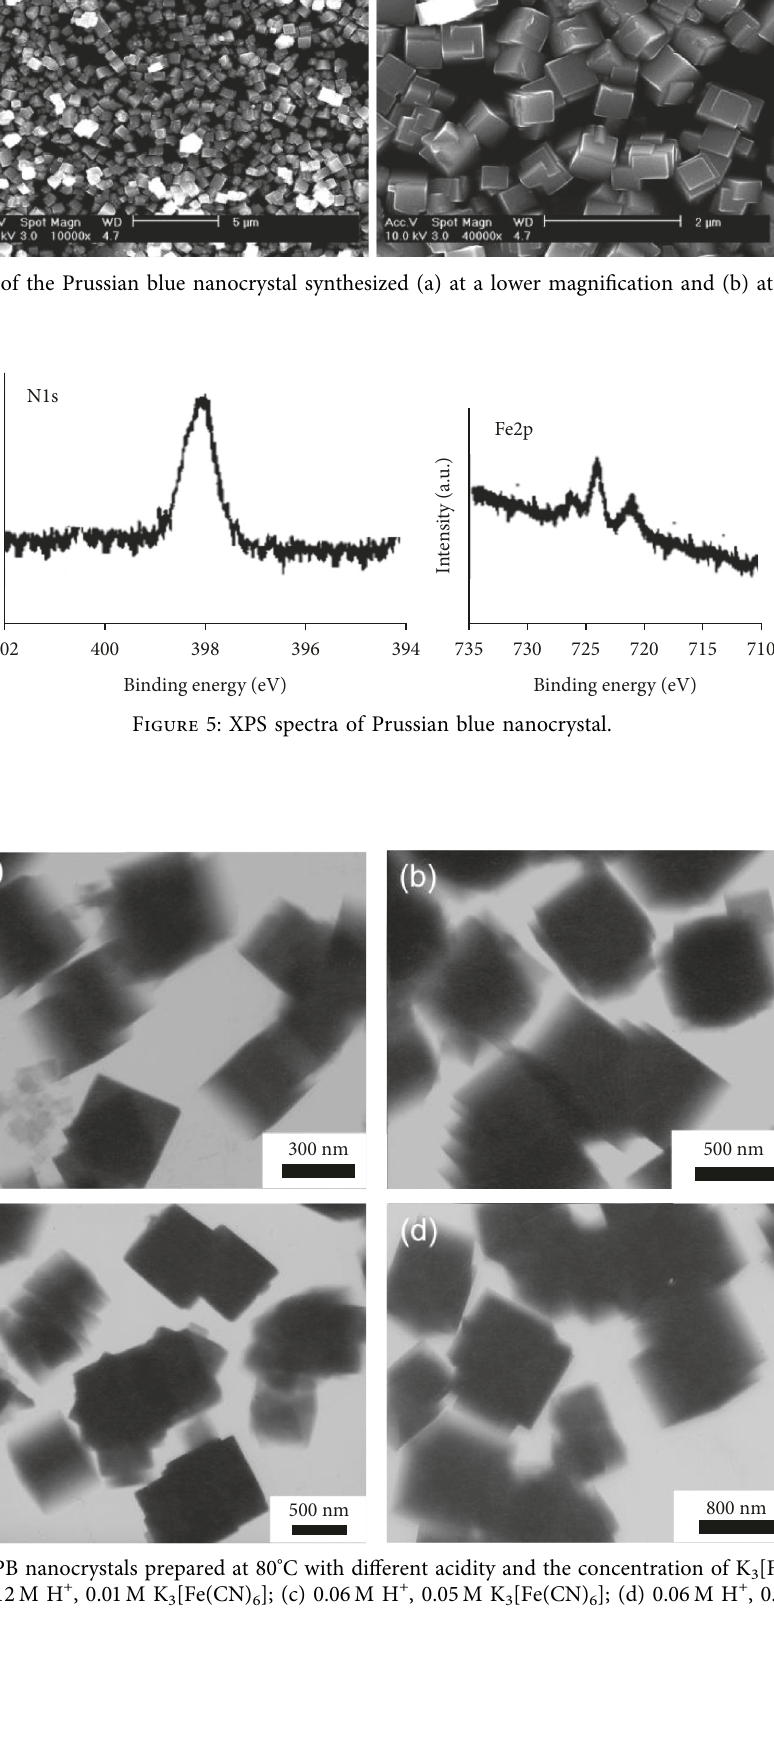
Figure 6: TEM images of PB nanocrystals prepared at 80 ° C with different acidity and the concentration of K 0.01M K 3 [Fe(CN) 6 ]; (b) 0.12M H + , 0.01M K 3 [Fe(CN) 6 ]; (c) 0.06M H + , 0.05M K 3 [Fe(CN) 6 ]; (d) 0.06 M H + , 0.10M K 3 [Fe(CN) 6 ].